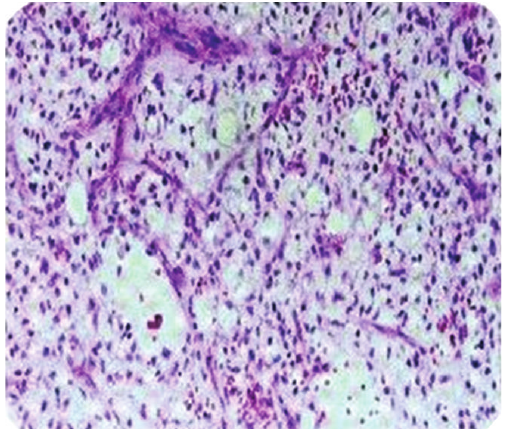
Figure 3: Showing histopathological picture of a well-di ff erentiated